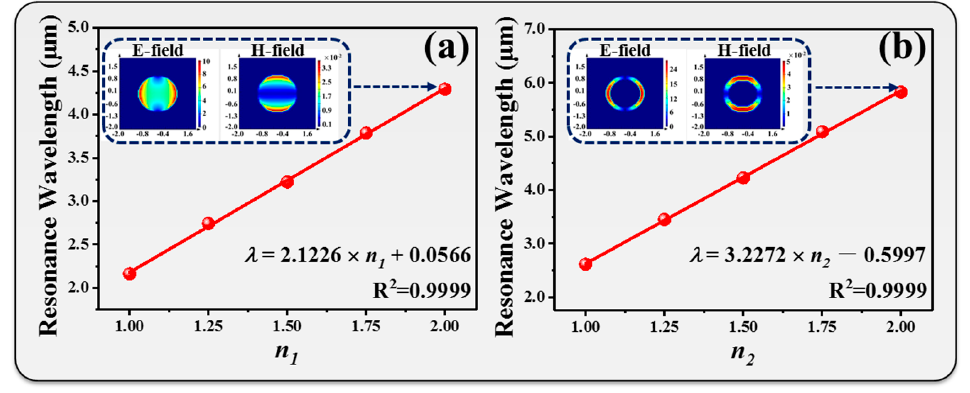
Figure 6. Relationships between resonances and deformation ratios for ( a ) circle-shaped and ( b ) ring-shaped metamaterials. The inserted images show the corresponding E- and H-field distributions.